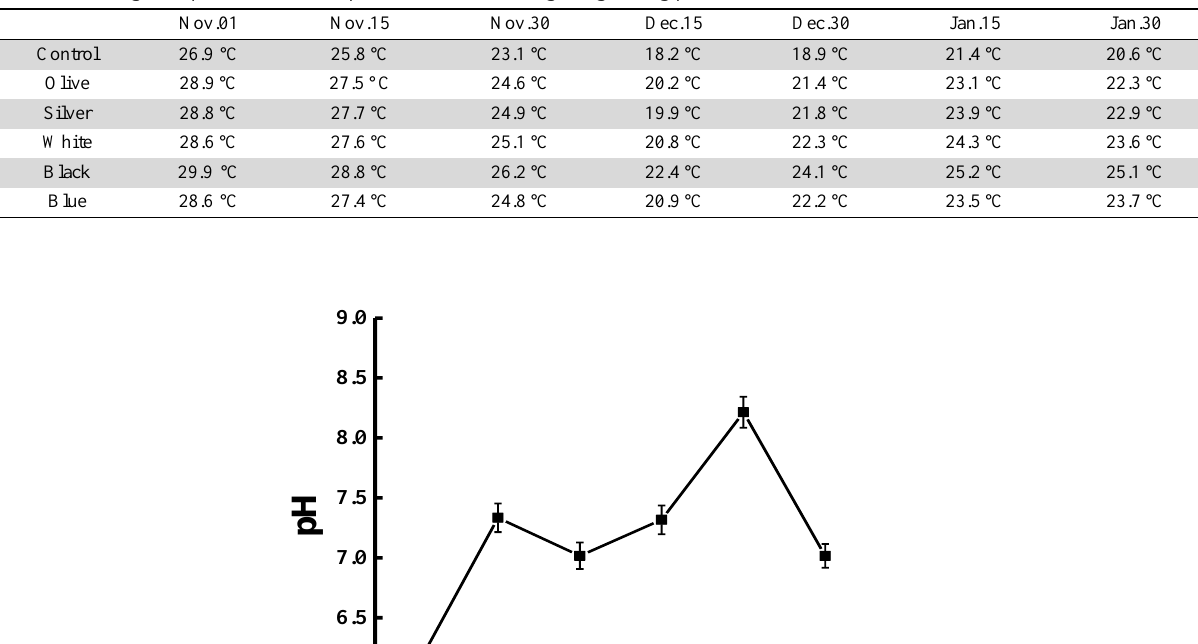
Table 2. Average temperature of the experimental field during the growing period